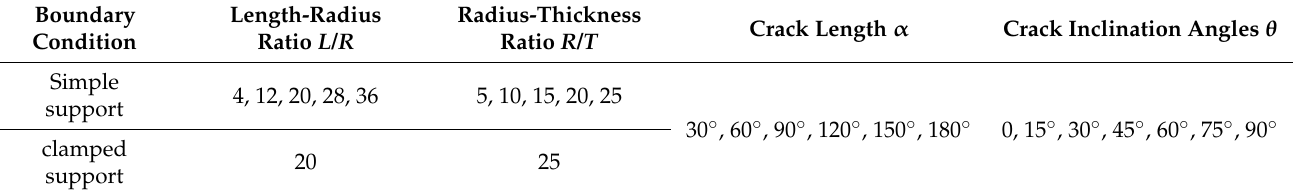
Table 3. Parameters for cracked cylindrical shell.